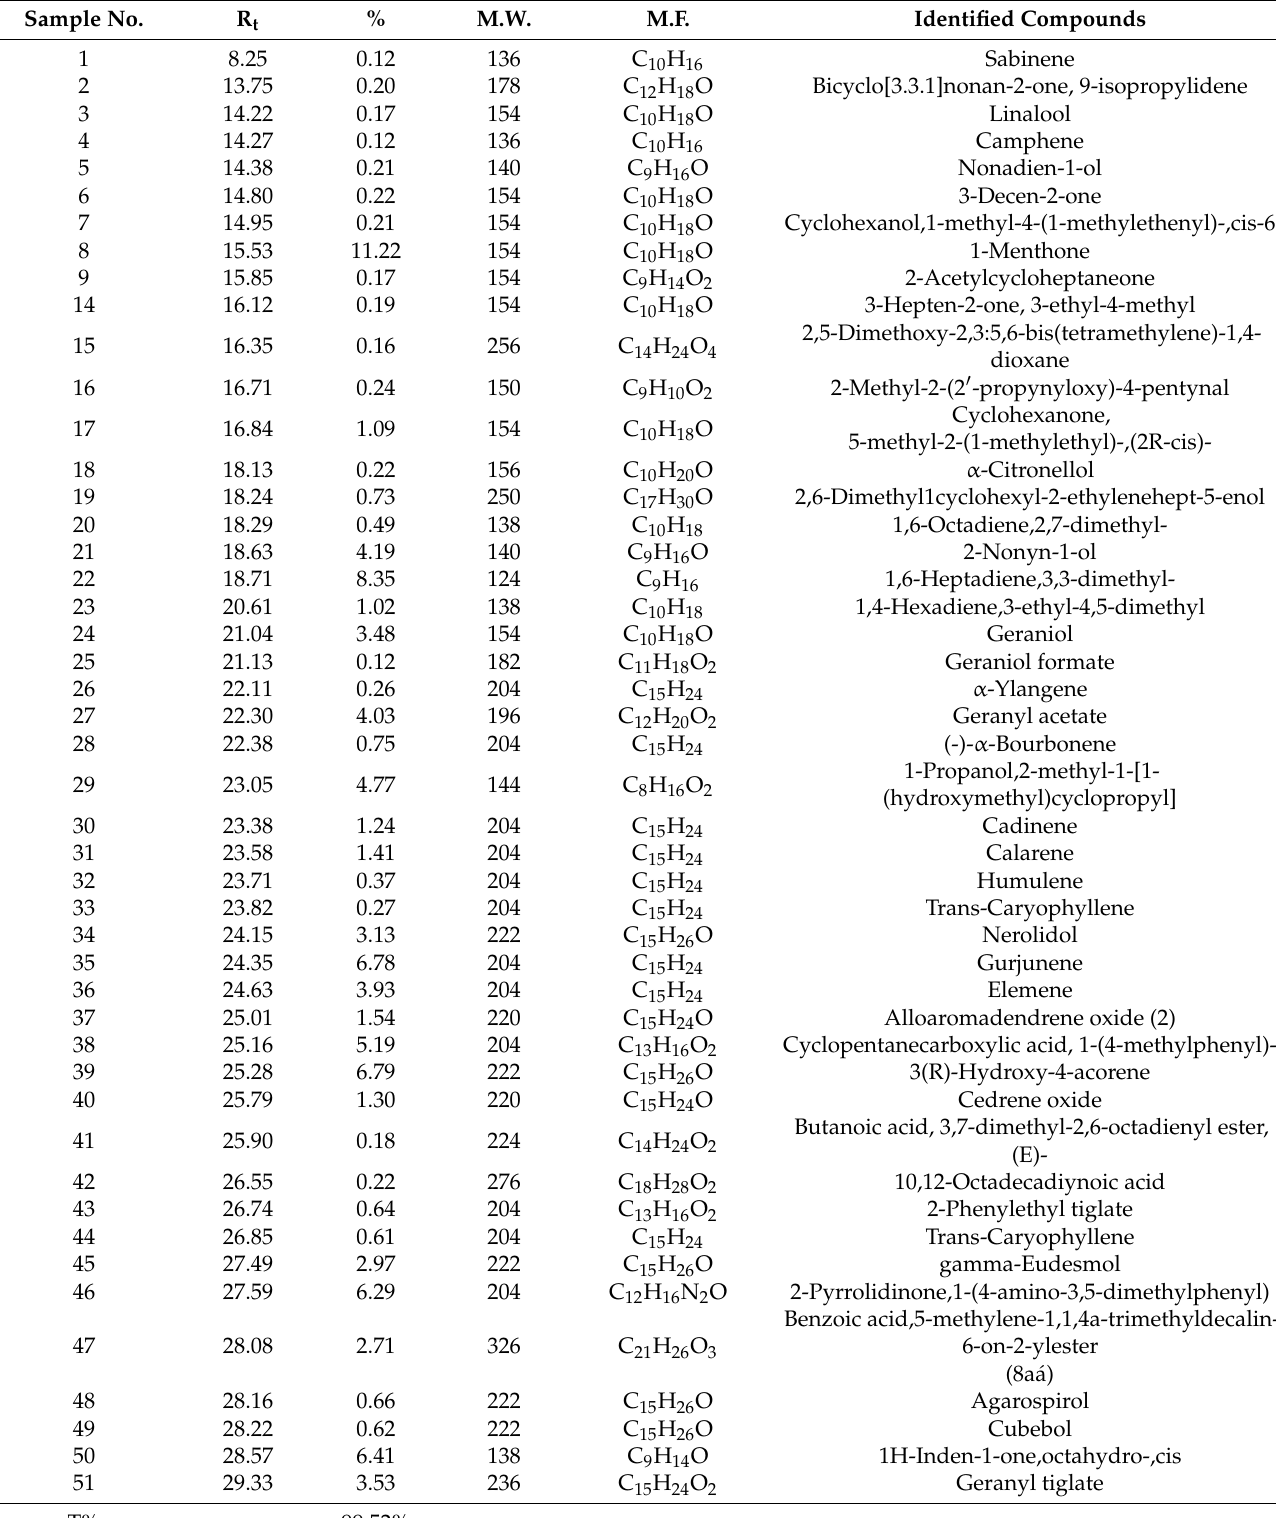
Table 1. Chemical constituents of anise oil extracted from the GC/MS